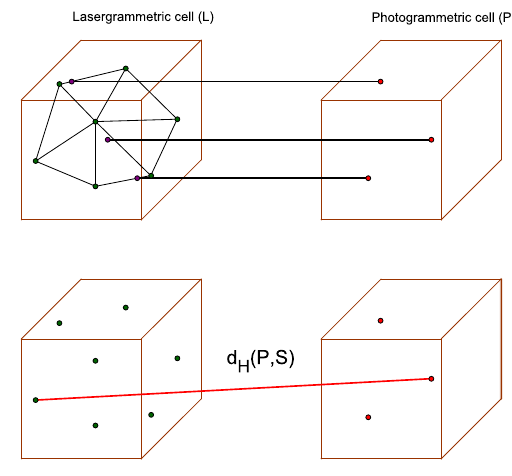
Figure 3: Homologous octree cell representation. Euclidean dis- tances are computed between points of the two clouds (top). Hausdorff distance (bottom) is also computed for filtering the Eu- clidean distances if required